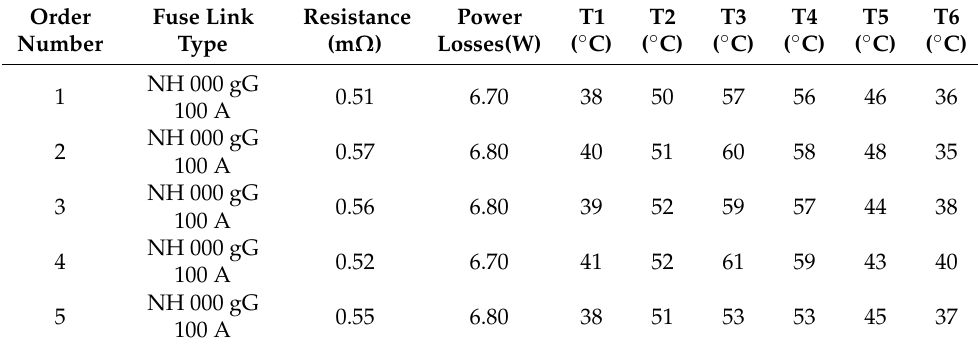
Table 2. Results obtained by Team A for fuse link type NH000 gG 100 A.